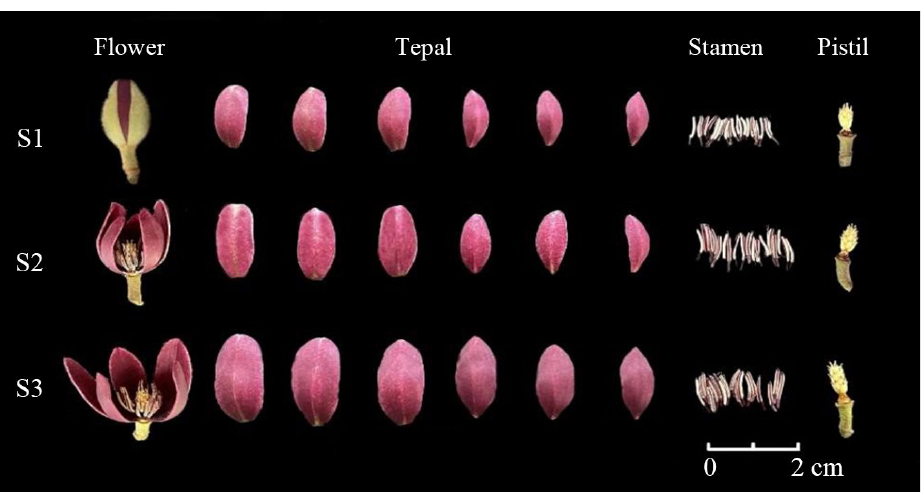
Figure 1. Typical samples of three flower development stages. S1: bud stage (length/cm 1.786 ± 0.016 c, the buds were swollen with cracked bracts, and the purple tepals were exposed); S2: initial flow- ering stage (length/cm 2.059 ± 0.049 b, the flowers were about to open, and the male and female stamens were exposed, and the pollen was not scattered); S3: full flowering stage (length/cm 2.444 ± 0.033 a, the inner and outer tepals were fully open, and the pollen was about to scattered). Different letters of flower length mean a significant difference p < 0.05.